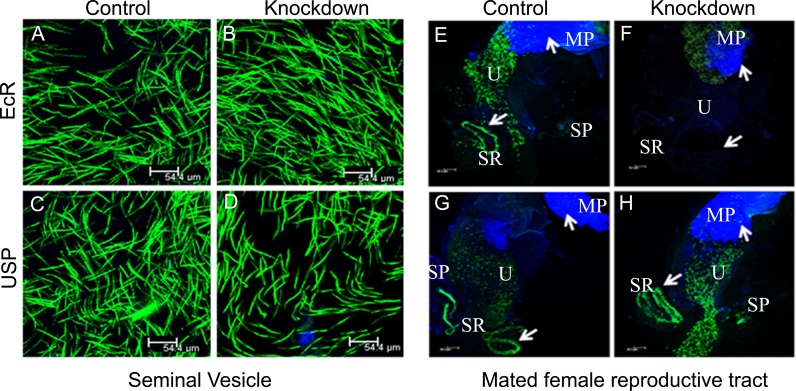
Analysis of sperm production in EcR knockdown males and their fate in mated females.To evaluate the effect of EcR knockdown (EcR-miRNA) on sperm, we first generated control and knockdown males that express GFP labeled sperm (ProtamineB-EGFP). Subsequently, observation of seminal vesicles from these males under a confocal microscope revealed comparable levels of GFP tagged sperm (green) in both controls (Panels A&C) as well as knockdown (EcR, Panel B or USP, Panel D) males, suggesting that sperm production is normal in these males. To test if these males are able to transfer sperm to females during mating, males knockdown for EcR or USP in their accessory glands were allowed to mate with Oregon-R virgin females. At 2h ASM, reproductive tracts from mated females were isolated and observed under confocal microscope for the presence of GFP-labeled sperm. Reproductive tracts from females mated to (E) EcR control, (G) USP control or (H) knockdown males contained mating plug (MP, blue) in the uteri (U) and GFP-labeled sperm (green) in the uteri as well as sperm storage organs, namely seminal receptacle (SR) and spermathecae (SP). However, reproductive tracts of females mated to EcR knockdown males (F) contained mating plugs but had sperm only in the uterus but not in SR and SP. These observations suggest that knockdown of EcR or USP has no detectable effect on sperm transfer but the sperm transferred by EcR knockdown males fail to move towards sperm storage organs and are not stored at levels comparable to those in controls.